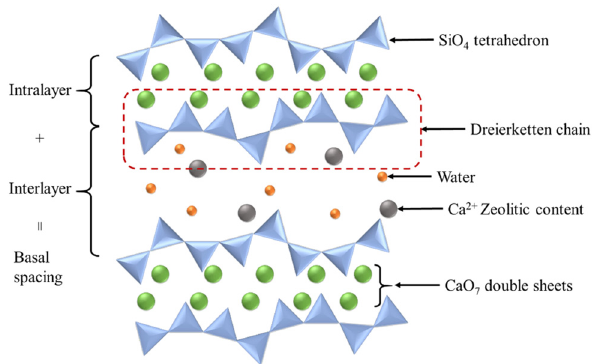
Figure 9: Schematic molecular model of 14 Å tobermorite, reprinted with permission from ref. [ 111 ] ; Copyright 2020,